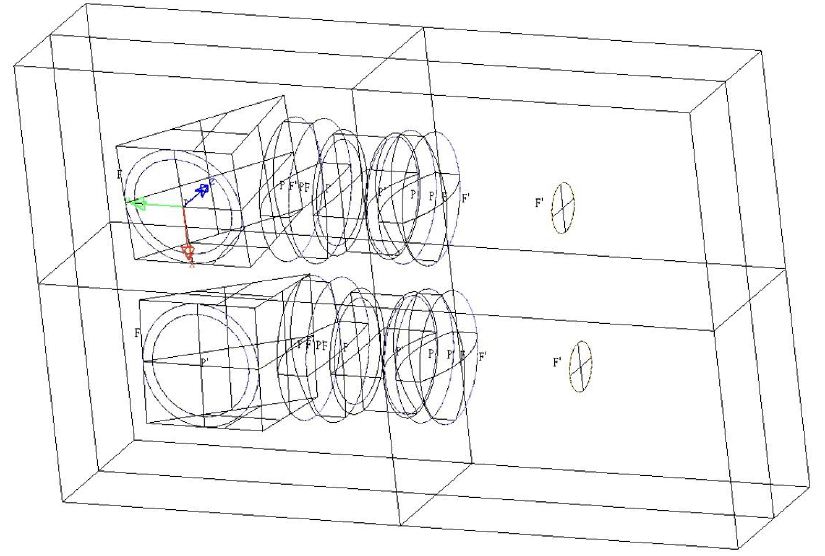
Figure 8. Structural relationship between human eyes and 3D ophthalmoscope glasses.